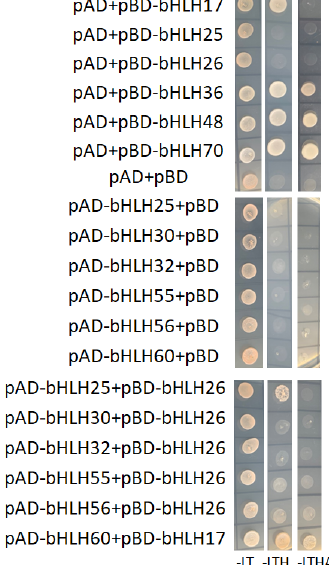
Figure 8. The protein–protein interactions between DobHLHs detected by Y2H. The sequences of DobHLH25, 30, 32, 55, 56, and 60 genes were ligated to the GAL4 activation domain (AD) while the sequences of DobHLH17, 26, 36, 48, and 70 genes were fused to the GAL4 DNA-binding domain (BD). SD-LT, SD-LTH, and SD-LTHA represent the SD-LeuTrp, SD-Leu-Trp-His, and SD-Leu-Trp-His-Ade medium, respectively.